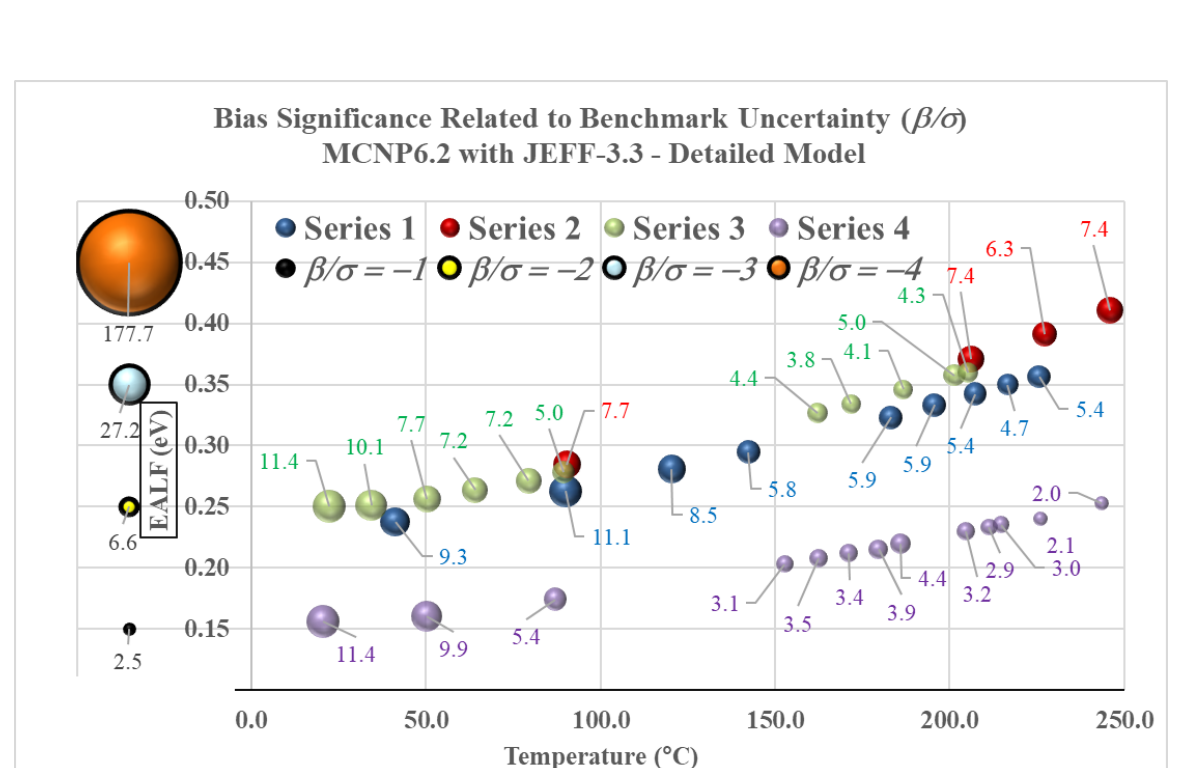
Figure 3. Bubble - Chart Showing KRITZ - 1 - Mk Significance Indicator Values from Table